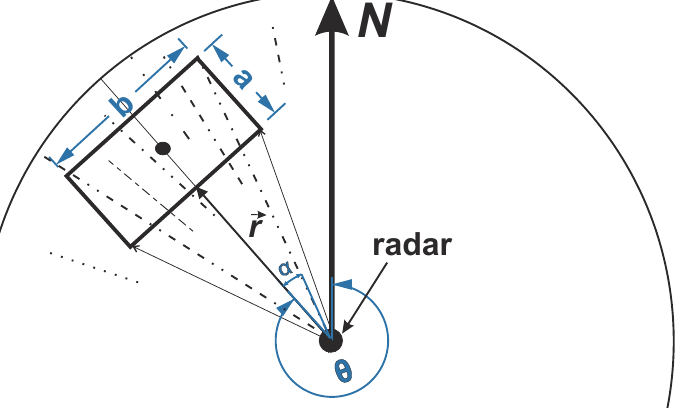
Figure 6. Geometry of the analysis box situation to understand the directional spikes component distribution in the spectral domain.